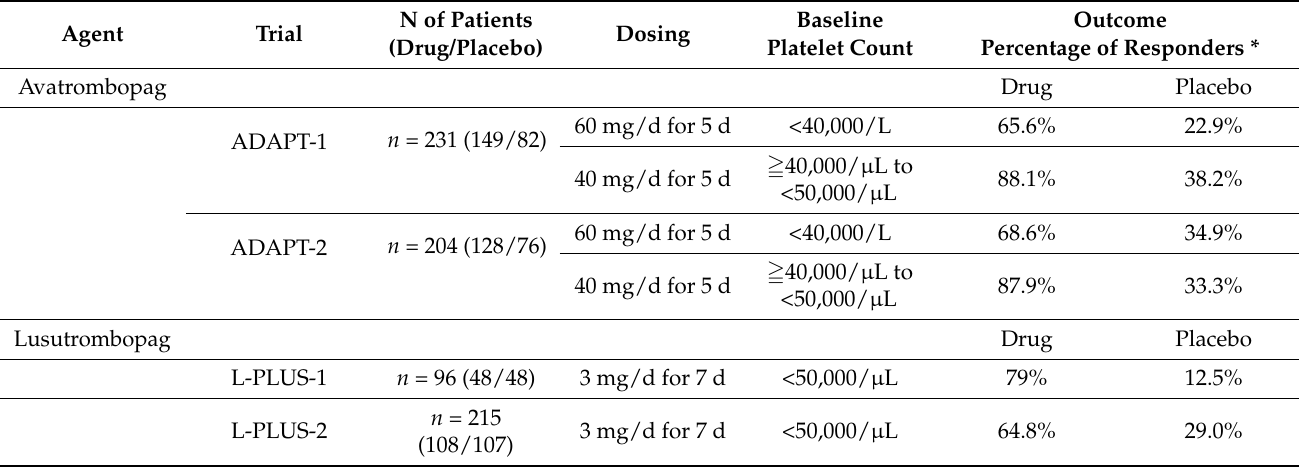
Table 1. Efficacy of second-generation TPO receptor agonists for the treatment of thrombocytopenia in patients with chronic liver disease scheduled for invasive procedures. Synopsis of results from four multicentric, randomized, double-blind, placebo-controlled phase-3 trials